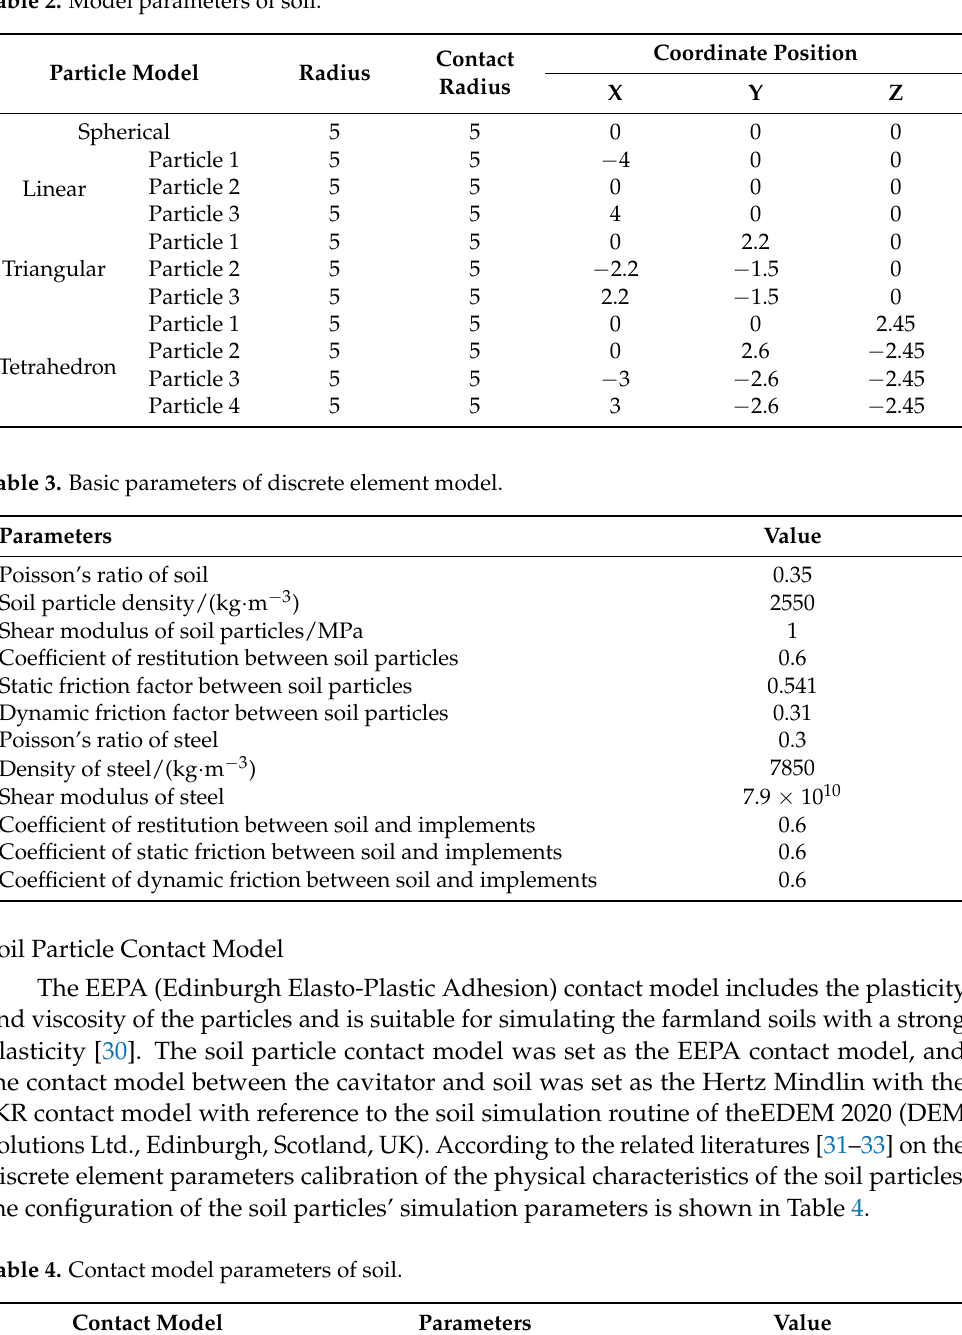
Table 2. Model parameters of soil.